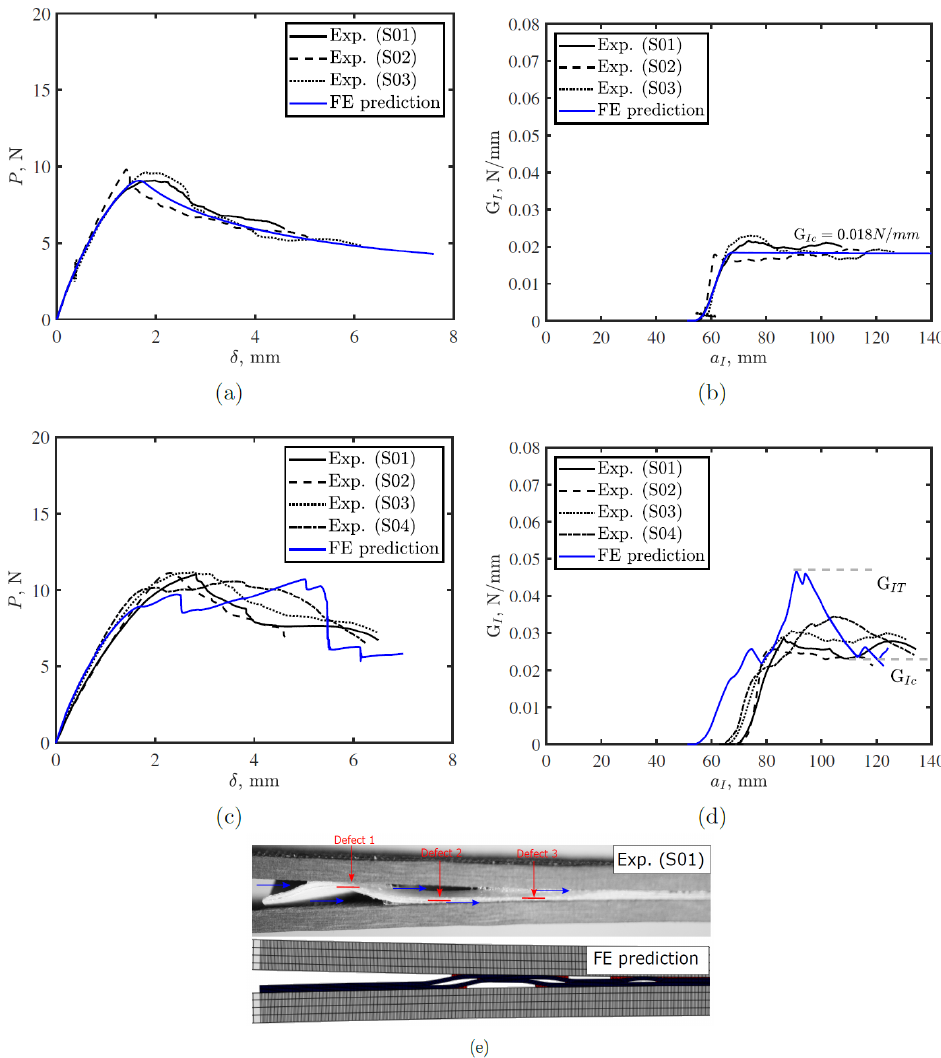
Figure 6. Proposed model prediction and experimental results for double cantilever bean test on: ( a , b ) conventional tapes, ( c , d ) toughened tape with 2 mm sacrificial defect and 5 mm gap, and ( e ) corresponding damage mode at 3 mm displacement for the toughened tape. In ( e ) the red lines represents the defect position and the blue arrows represent the crack propagation